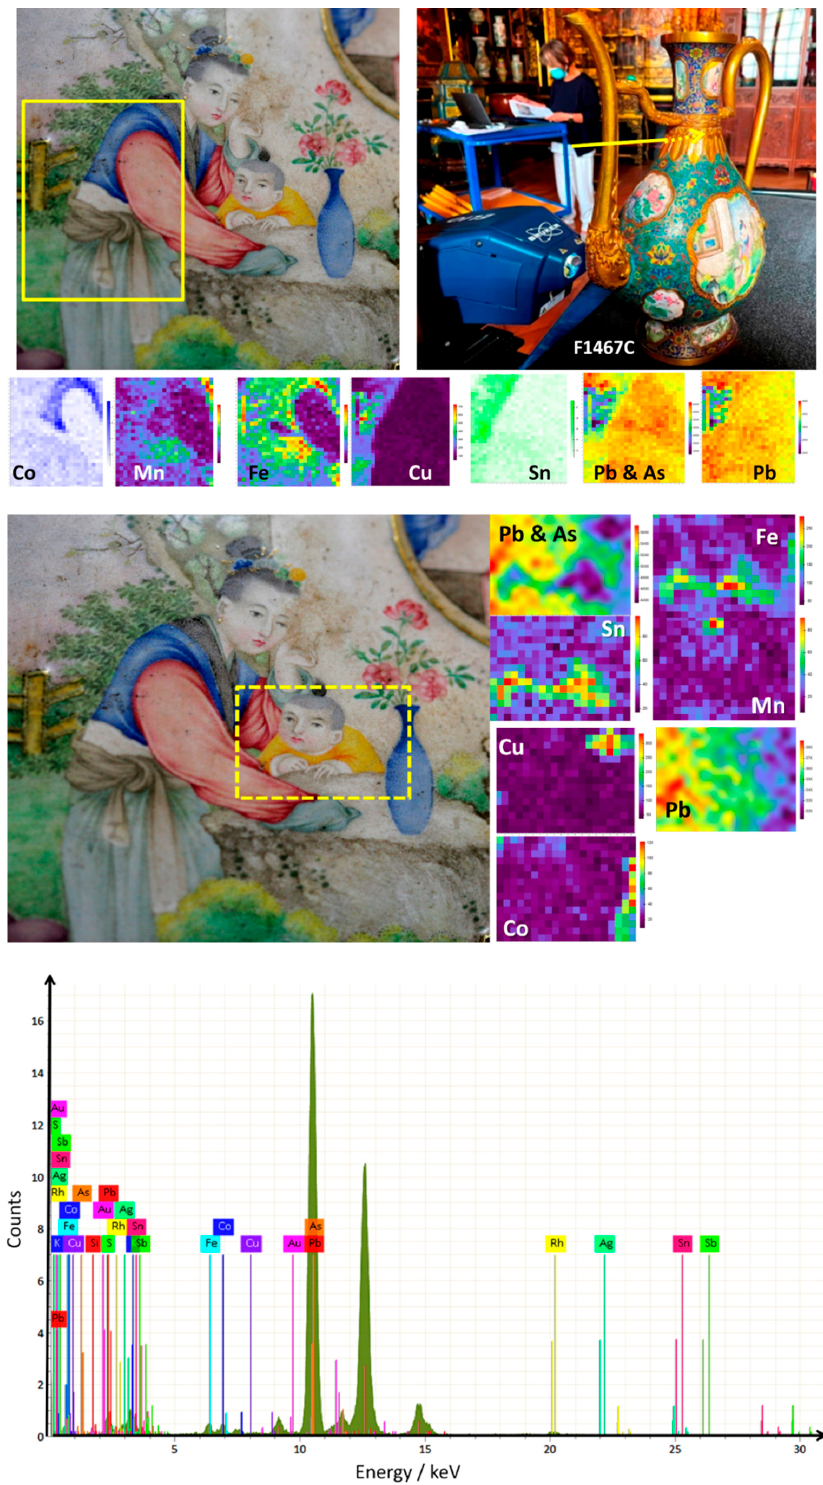
Figure 7. pXRF maps recorded on the painted décor depicting a woman with a child in the garden. The two mapped areas are delimited with a yellow line. The optical pixel image and corresponding distribution of elements (Co, Mn, Fe, Pb, Cu, Sn and Pb + As) are shown. An example of an XRF spectrum recorded on the darkest blue area of the woman’s vest in the painted décor.